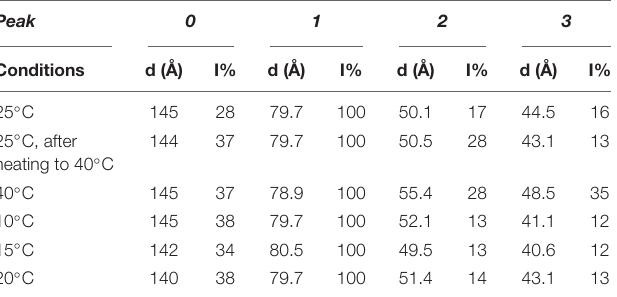
TABLE 3 | SAXD data for 70 wt% brain lipid extract in 0.9 wt% (154 mM) NaCl and 1 mM CaCl 2 as a function of temperature. Peak 0 2